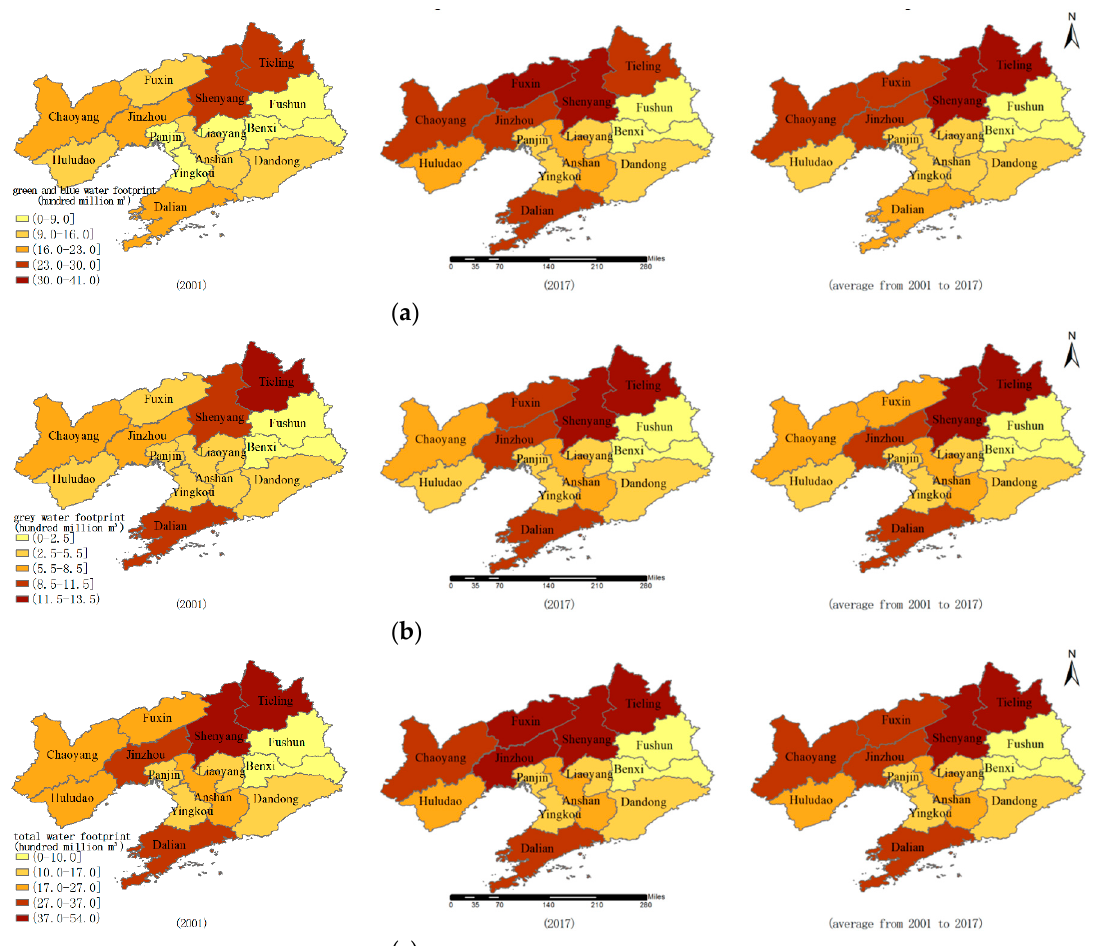
Figure 3. The spatial distribution of water footprint in Liaoning Province. ( a ) The spatial distribution of crop growth water footprint of every city. ( b ) The spatial distribution of crop pollution water footprint of every city. ( c ) The spatial distribution of crop production water footprint of every city.